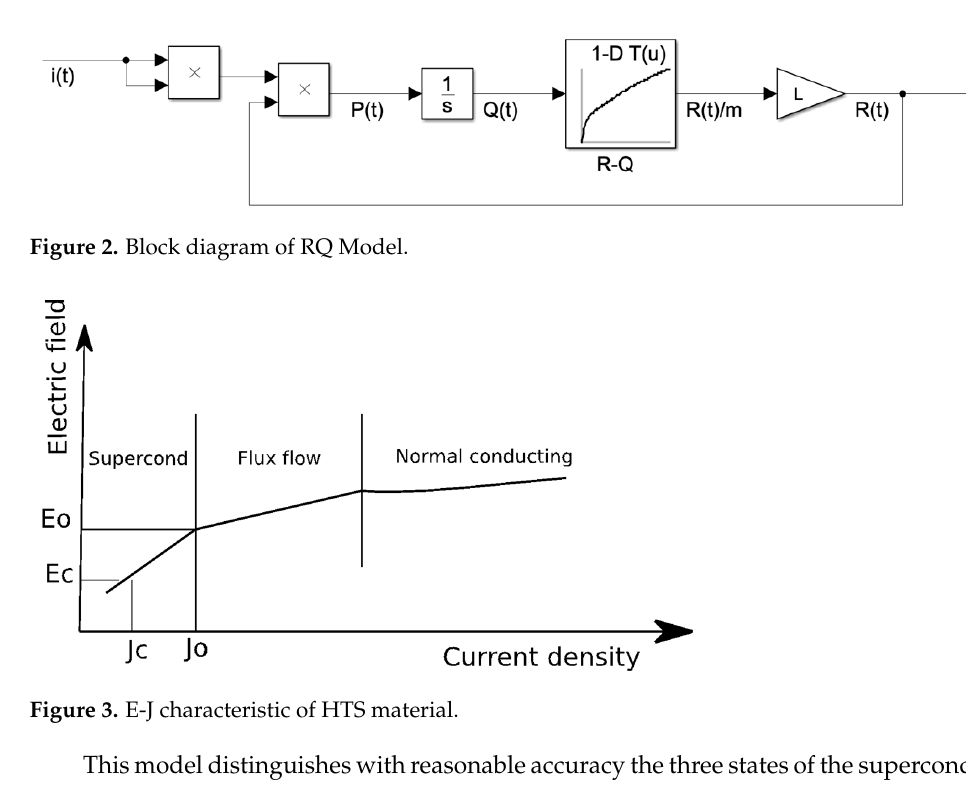
Figure 1. Step and exponential model comparison.